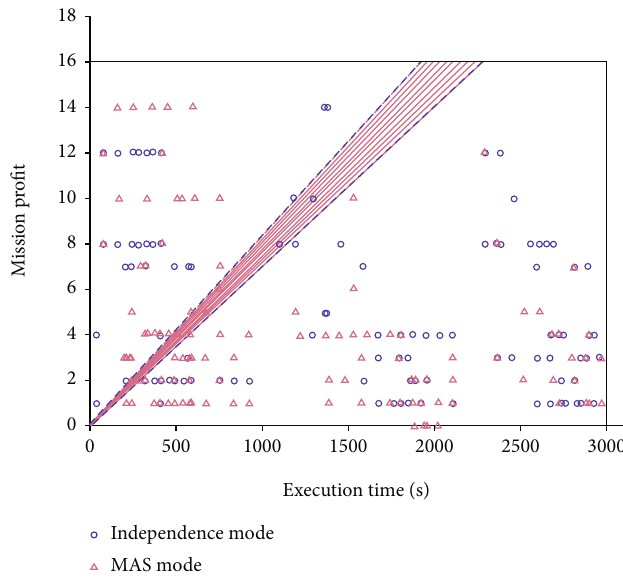
Figure 6: The boundaries and envelopes of the clustering result of the independence mode and the MAS